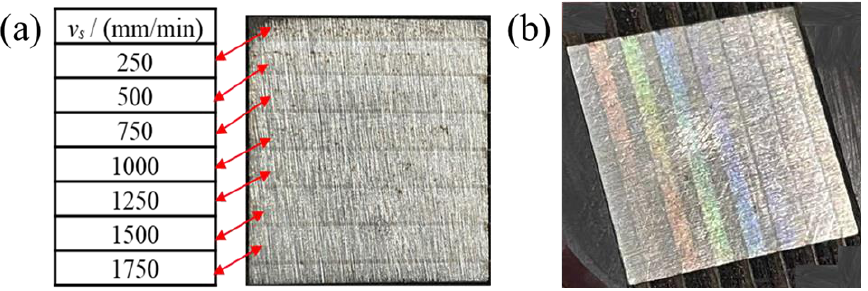
Figure 11. The morphologies of polished surface. ( a ) Macroscopic image showing the coupled laser polished surface; ( b ) Color change of polished surface. polished surface; ( b ) Color change of polished